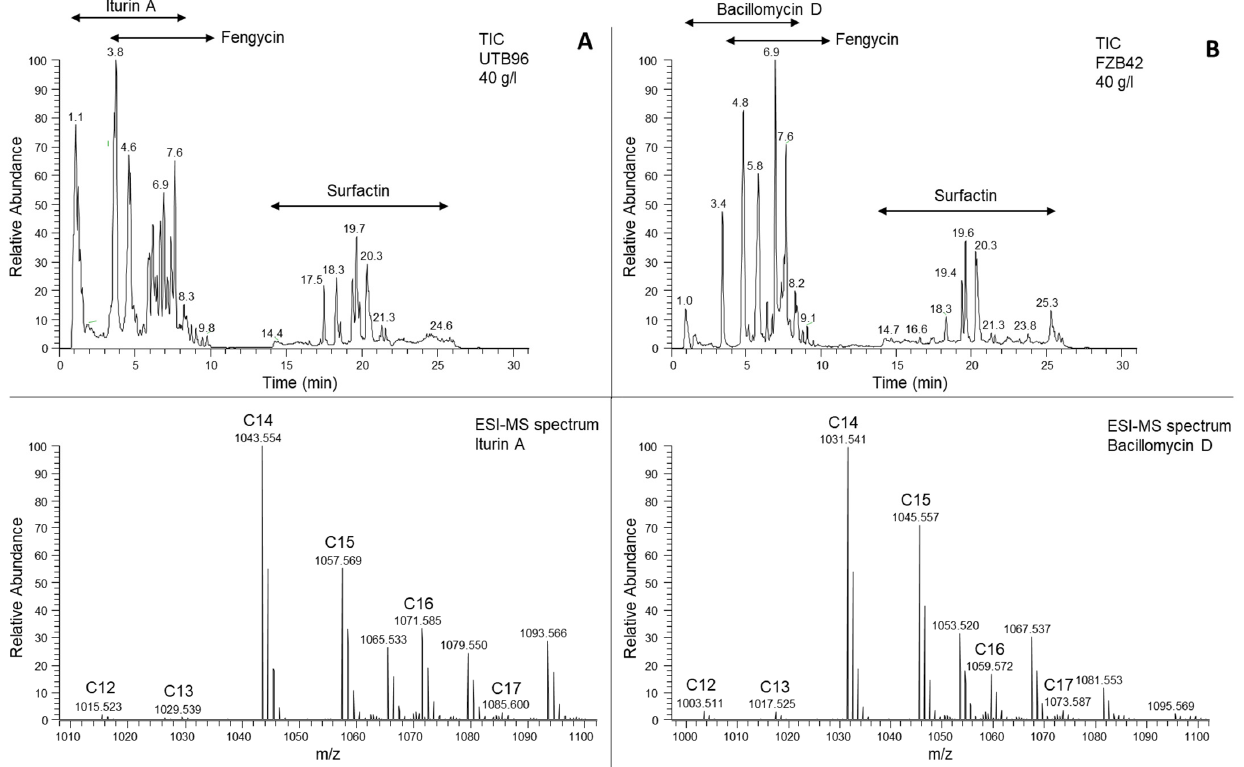
Figure 2. LC-ESI-MS analysis of the lipopeptide compounds produced by the B. velezensis UTB96 and B. velezensis FZB42 strains. ( A ) Total ion chromatogram (TIC, upper panel) and ESI-MS spec- trum (lower panel) of the extracted iturin A lipopeptides from B. velezensis UTB96. The ESI-MS spec- trum shows m/z values of protonated iturin A lipopeptides [M+H] + eluted in the time interval from 0.8–8 min. Fatty acid chain length of different iturin A lipopeptides is indicated. ( B ) Total ion chro- matogram (TIC, upper panel) and ESI-MS spectrum (lower panel) of the extracted bacillomycin D lipopeptides B. velezensis FZB42. The ESI-MS spectrum shows m/z values of protonated bacillomy- cin D lipopeptides [M+H] + eluted in the time interval from 0.8–8 min. Fatty acid chain length of different bacillomycin D lipopeptides is indicated.